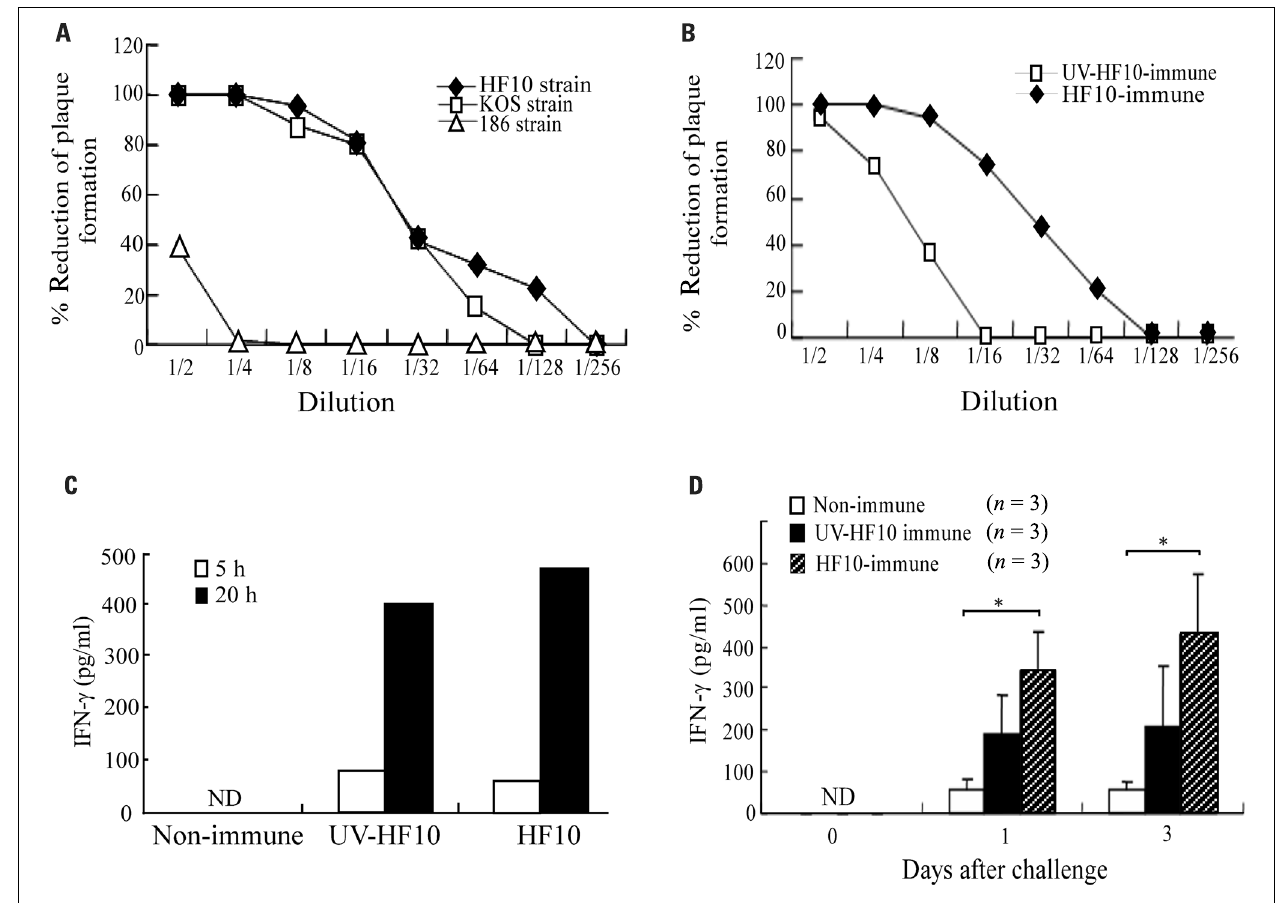
FIGURE 4 | Immune responses of HF10-immunized mice. (A) Serum was obtained from HF10-immunized mice ( n = 3), and its neutralizing ability against HSV-1 strains (HF10 and KOS) and an HSV-2 strain (186) was investigated by the reduction in plaque formation. (B) Mice were immunized with UV-inactivated HF10 or HF10. After 4 weeks, serum ( n = 3) collected and neutralizing ability against HF10 was assayed by the reduction in plaque formation. (C) IFN- γ produced by splenocytes stimulated with HSV-2 strain 186-infected NIH3T3 cells. Splenocytes (1 × 10 7 cells/dish) from unimmunized ( n = 3), UV-inactivated HF10-immunized ( n = 3), or